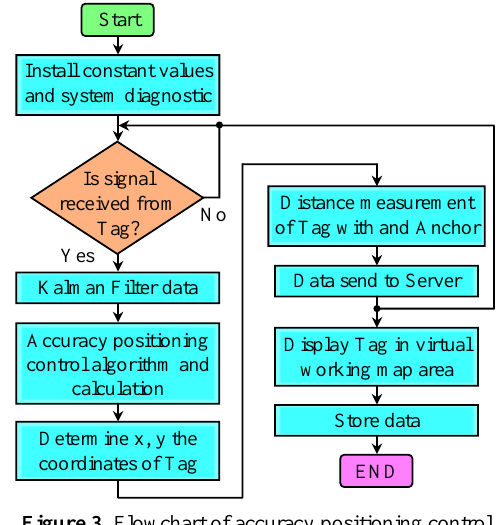
Figure 3. Flowchart of accuracy positioning control algorithm in